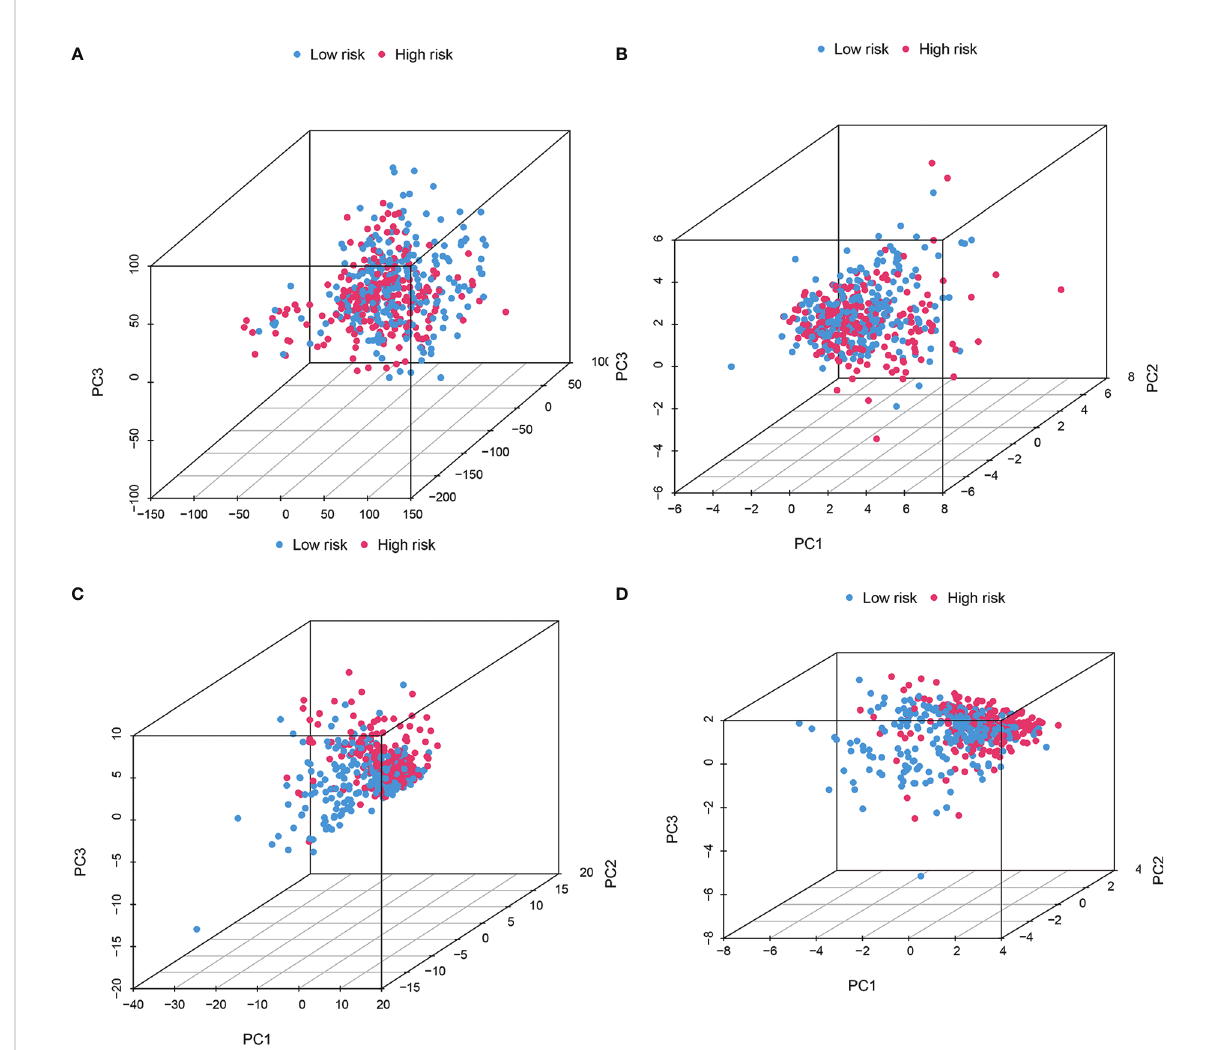
FIGURE 7 The Low-risk and high-risk groups displayed different stemness statuses. The two risk groups ’ principal component analysis on the basis of (A) entire gene expression pro fi les, (B) 19 cuproptosis genes, (C) 8 cuproptosis-related lncRNAs, as well as (D) risk model constructed by eight cuproptosis-related lncRNAs representation pro fi les in TCGA cohorts. The results showed that the low-risk and high-risk groups based on the cuproptosis-related lncRNAs and risk model were distributed in distinct